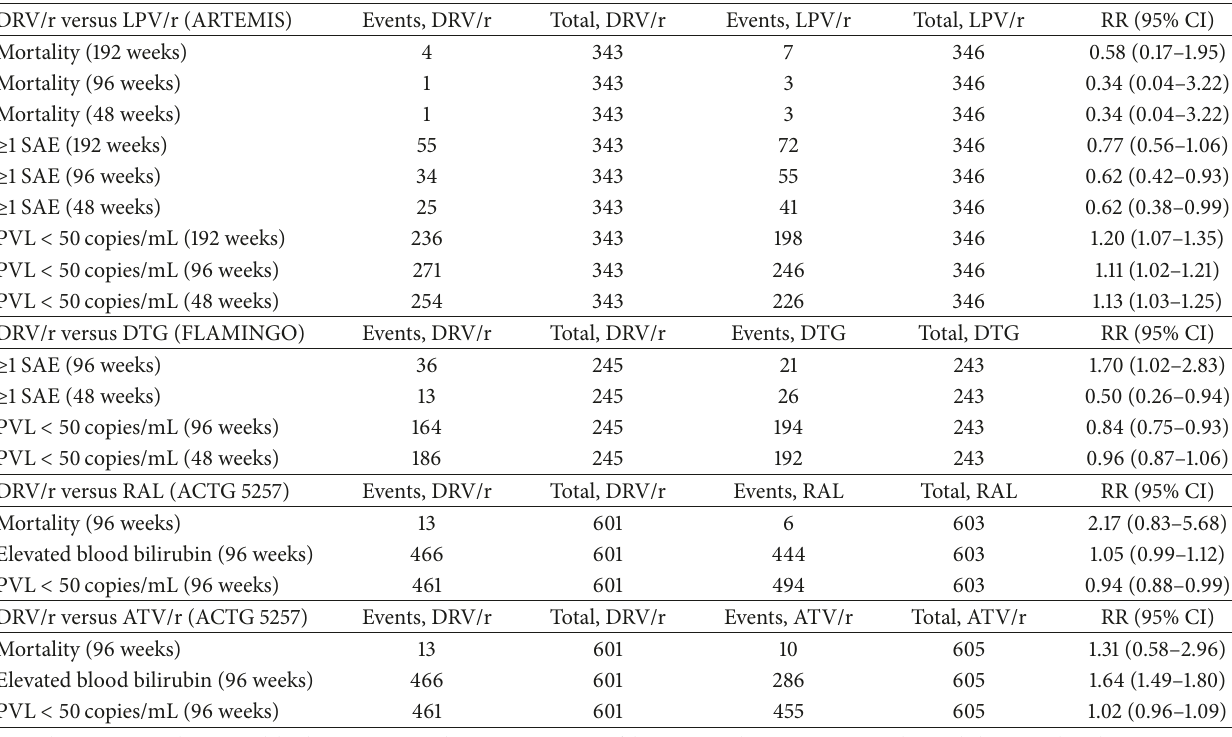
Table 2: Quantitative data for trial outcomes (dichotomous).